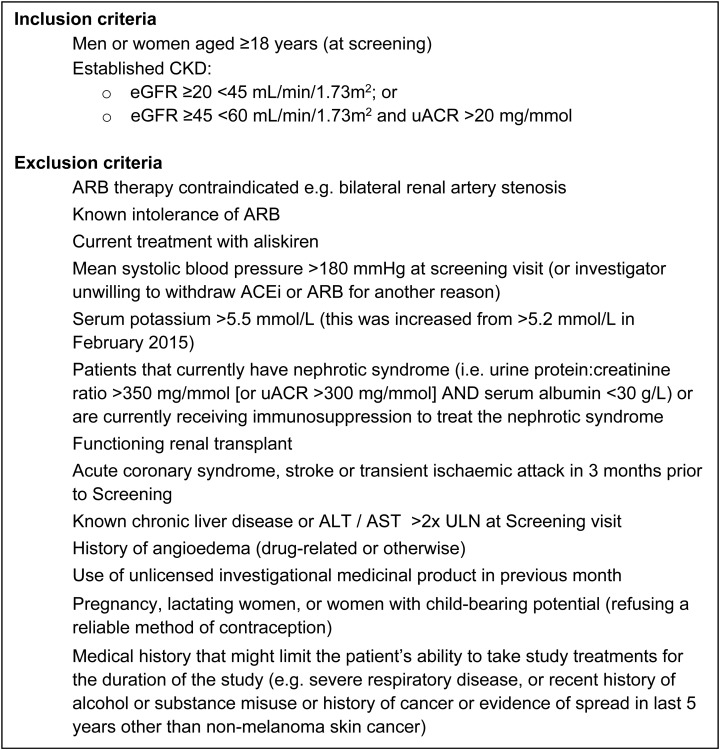
Inclusion and exclusion criteria. ALT, alanine aminotransferase; AST, aspartate aminotransferase; ULN, upper limit of normal.